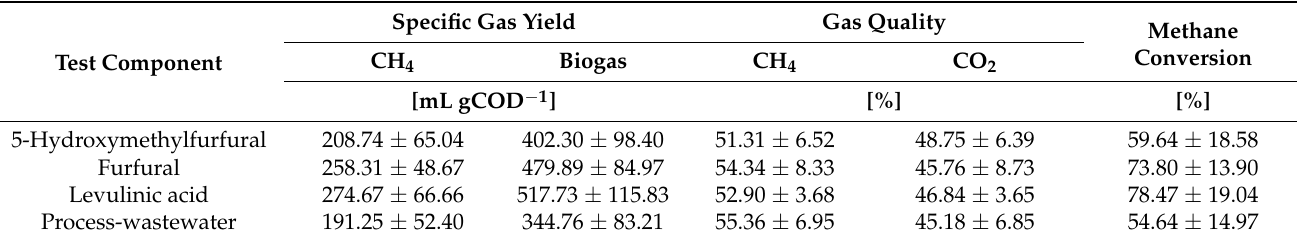
Table 3. Mean specific gas yields, mean produced biogas content, and mean percent degradation of the individual test component at 48 h after their administration into the anaerobic